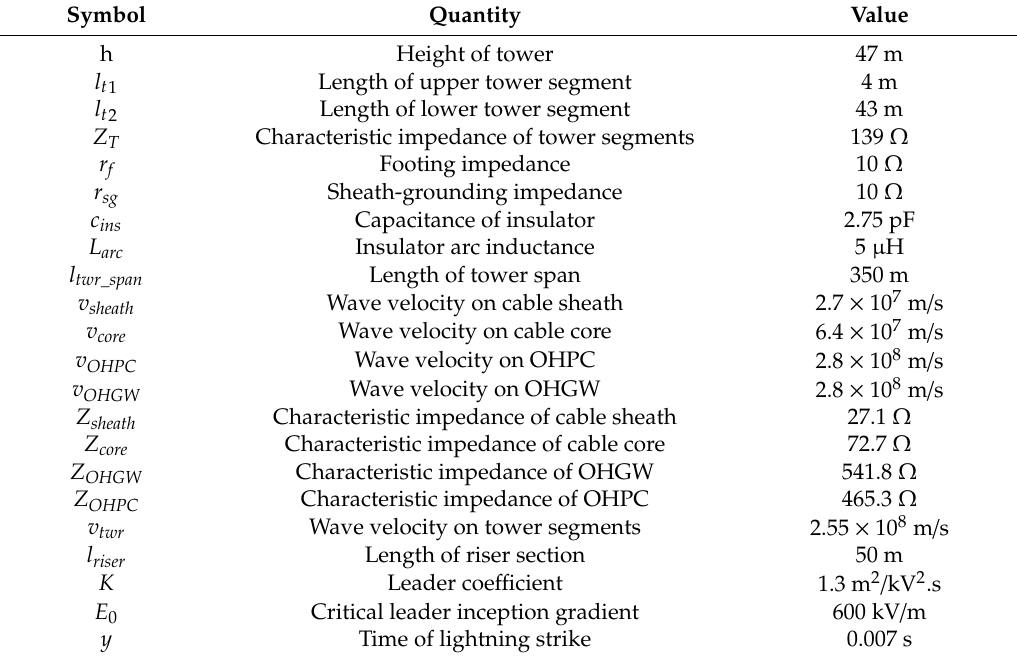
Table 1. Values of electromagnetic transient (EMT) simulation model